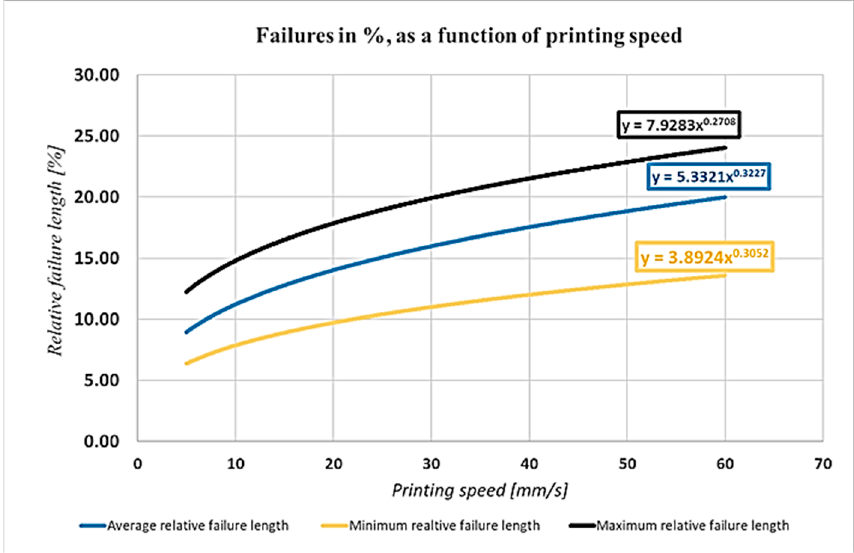
Figure 8. Effect of the printing speed.